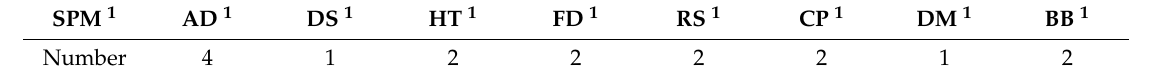
Table 15. Number of signal processing modules.